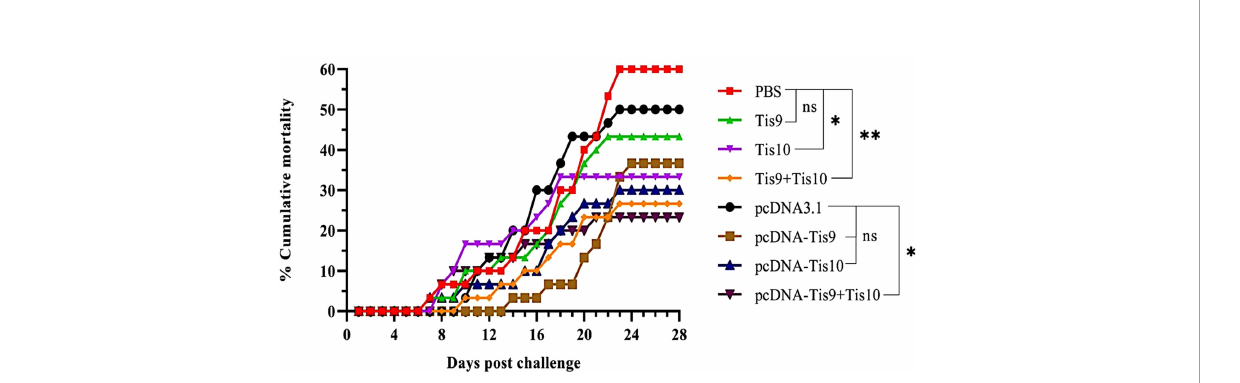
FIGURE 3 Cumulative mortality curves of the recombinant protein vaccines (Tis9, Tis10 and Tis9+Tis10 groups) and DNA vaccines (pcDNA-Tis9, pcDNA- Tis10 and pcDNA-Tis9+Tis10 groups) after challenge with 1 x 10 5 TCID50 of TiLV. Differences among the groups were analyzed using one-way ANOVA and Tukey ’ s post hoc tests. Statistical signi fi cance is indicated by single asterisk (*, P < 0.05) or double asterisks (**, P < 0.01) or ns (not signi fi cant) compared to the PBS or pcDNA3.1 (negative control) groups at the termination day (day